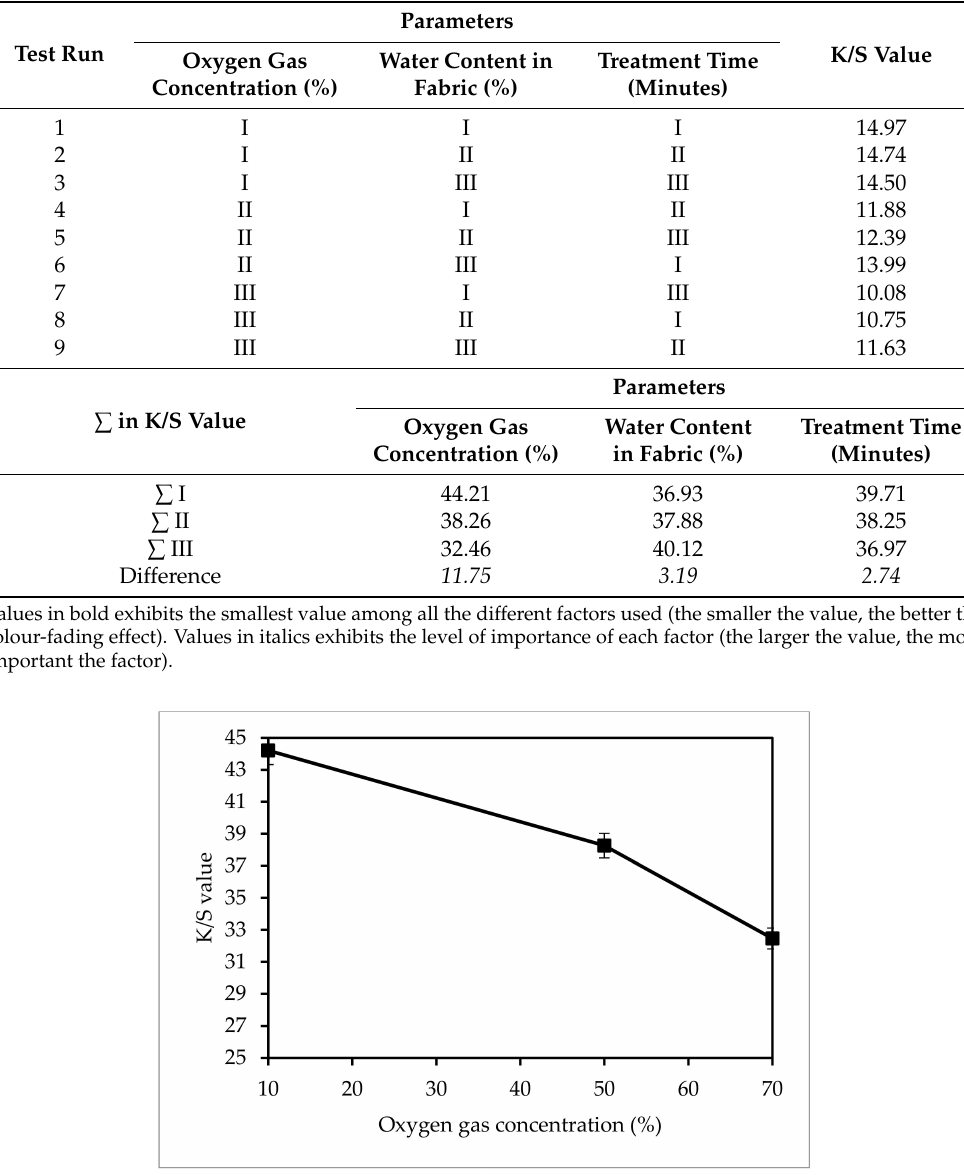
Figure 2. Effect of oxygen gas concentration in plasma-induced ozone colour-fading effect on the sulphur-dyed knitted cotton